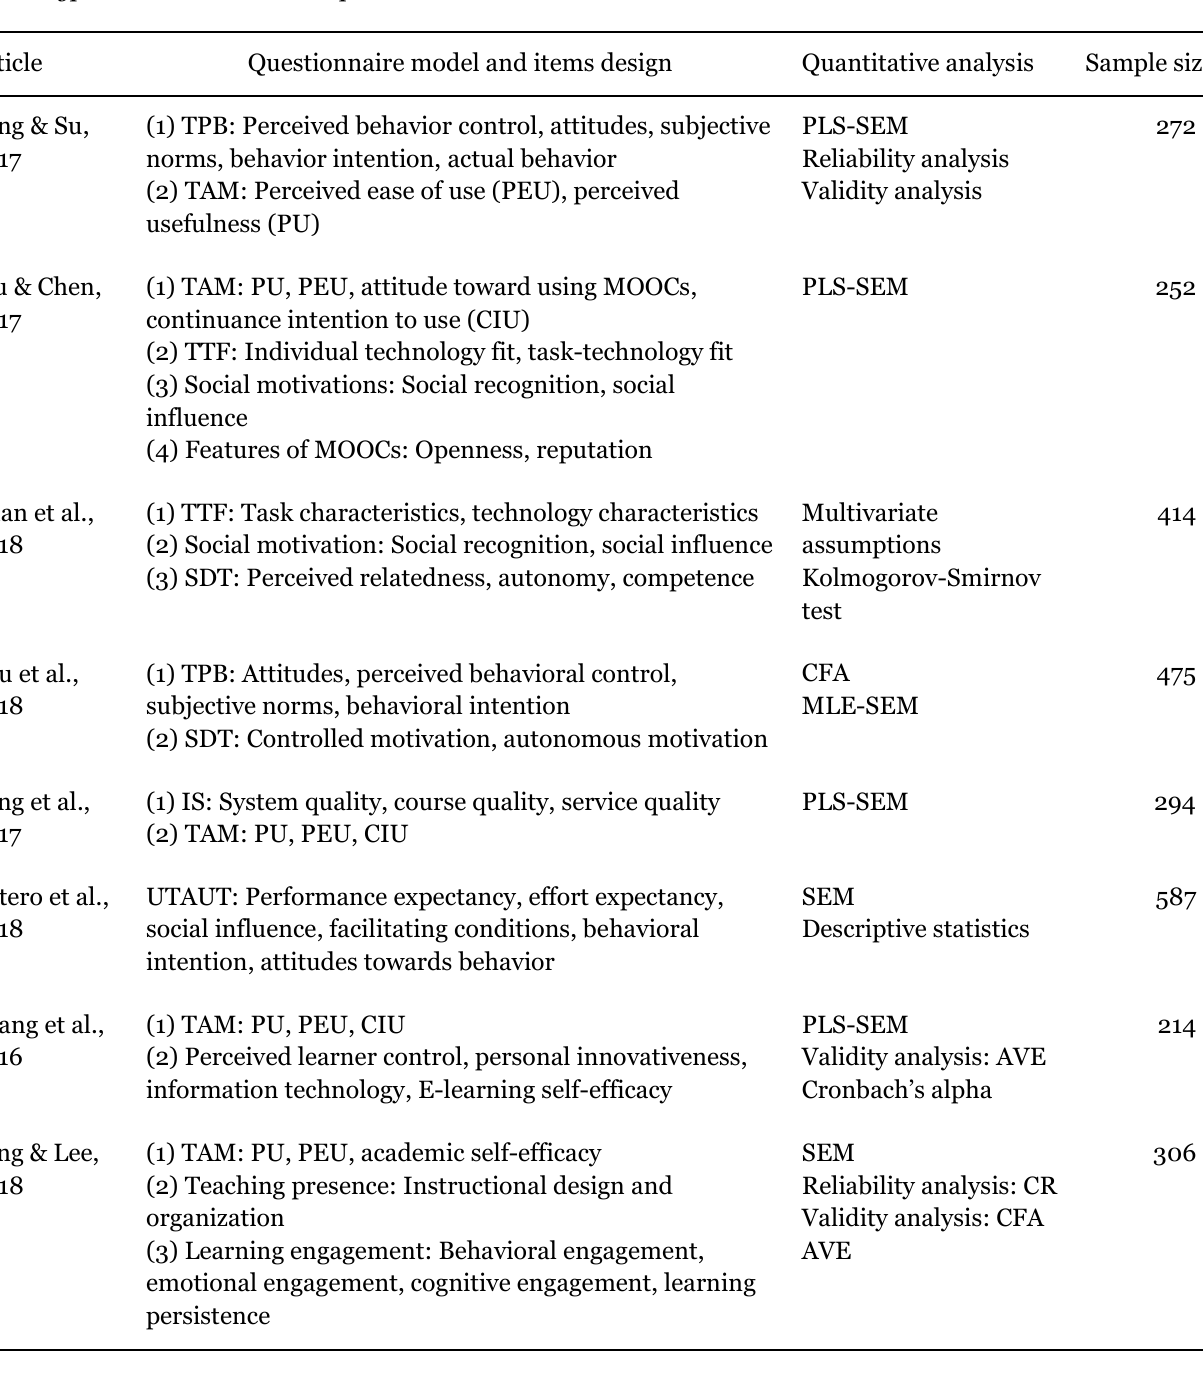
12 Typical Articles About Dropout Rate or Continuance Intention to Use